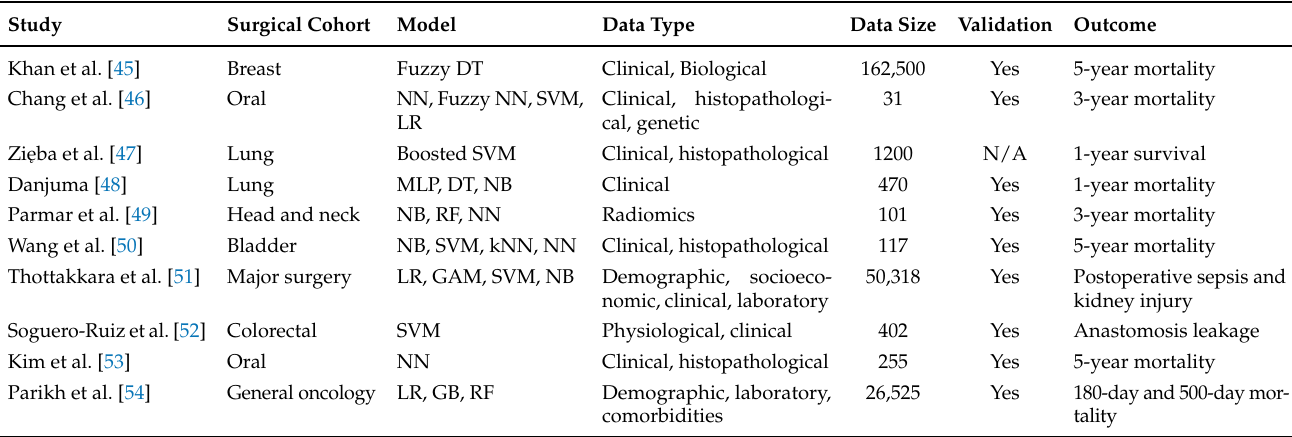
Table 2. Compilation of machine-learning studies in postoperative prognostics, according to the major taxonomic dimen- sions (literature references in chronological